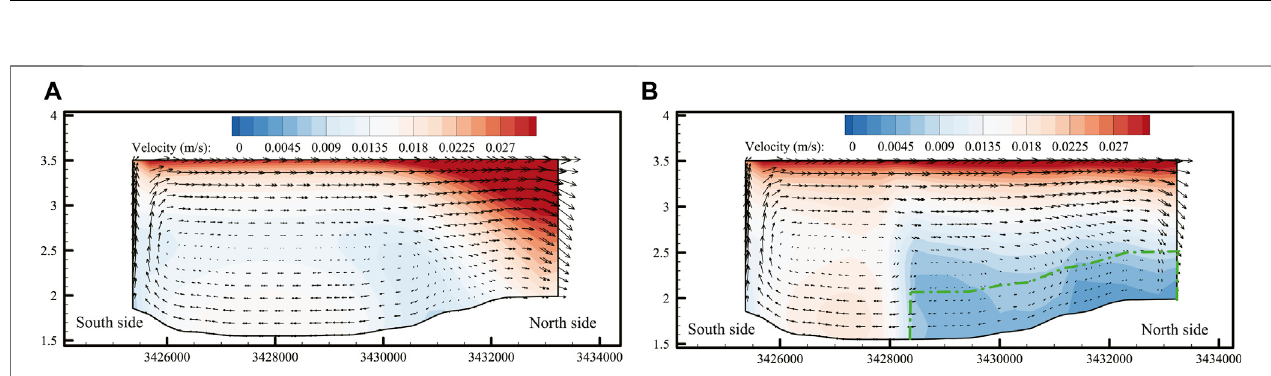
FIGURE 10 | Vertical velocity distribution of the section of Dongtaihu Bay in July; green dots in the fi gure represent vegetation patches. (A) Without vegetation and (B) with vegetation.